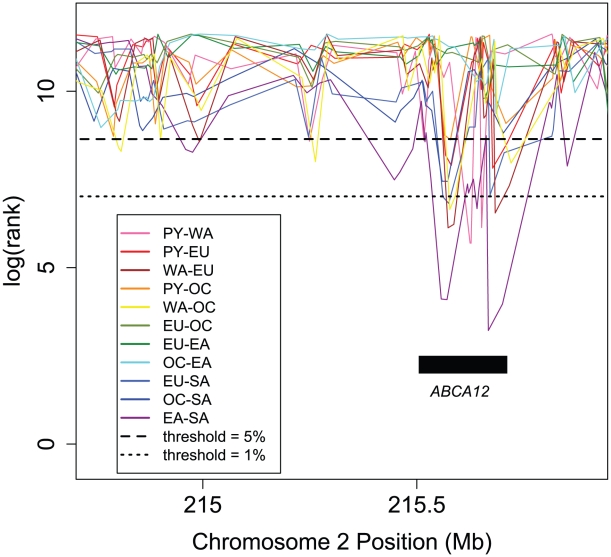
Ranks of FST in a section of Chromosome 2, illustrating parallel divergence at ABCA12.For each group pair, values of FST at all 111,724 globally polymorphic, intermediate frequency SNPs have been ranked, shown on a log scale (y-axis); here, lower rank corresponds to higher FST. Multiple group pairs show very low ranks due to high FST across ABCA12, with several exceeding a 1% threshold. Mutations in this skin keratinization gene cause harlequin ichthyosis [27]. The orientations of the most extreme divergence comparisons indicate that one allele is common in Africa and South America, while the other is common in Europe, Oceania, and East Asia. Rank lines have been staggered slightly for ease of visualization. ATP-binding cassette (ABC) transporters like this one are enriched among parallel divergent genes (Table S3) and are linked to multi-drug resistance, macular degeneration, breast cancer, diabetes, and other diseases.